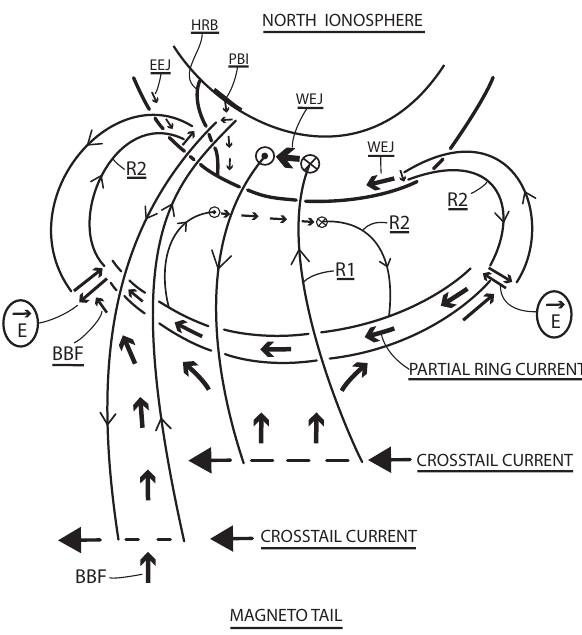
Fig. 1. Schematic illustration of M–I coupling via three categories of current systems applicable to substorms: Bostrøm type 1 in two variants (substorm current wedge, SCW, in the midnight sector and wedgelets related to BBFs) and Bostrøm type 2 currents on the dusk and dawn sides. Ionospheric Pedersen current closures of R1 and R2 FACs across the Harang reversal boundary (HRB) with their con- nections to the magnetosphere are indicated. The Bostrøm type I systems are powered by earthward-directed plasma intrusions and disruptions of the cross-tail current (CTC) giving rise to R1-type FACs. Bostrom type II systems are powered by plasma intrusion to the plasma sheet–partial ring current boundary and channels of flow braking ( J perp × B − force) representing dynamo action ( E · J < 0) with associated excitation of field-aligned current (FAC) sheets. in the ionosphere (after Bostrøm, 1977) are indicated as well